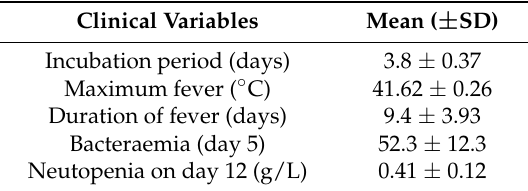
Table 1. Mean ( ± SD) values of clinical variables in 12 young, previously unmated ewes inoculated with Anaplasma phagocytophilum -infected